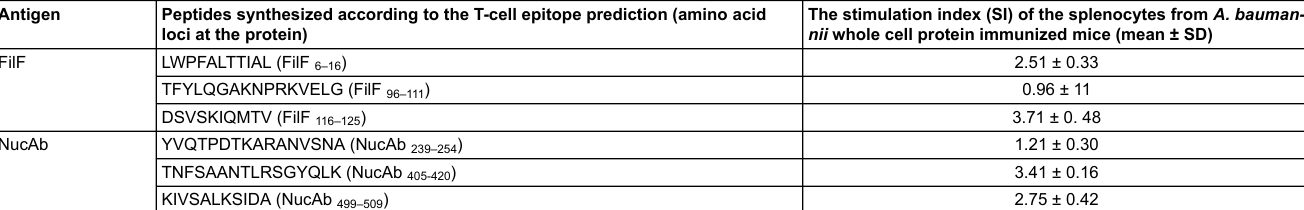
The stimulation index (SI) of the splenocytes from A. bauman- nii whole cell protein immunized mice (mean ± SD)